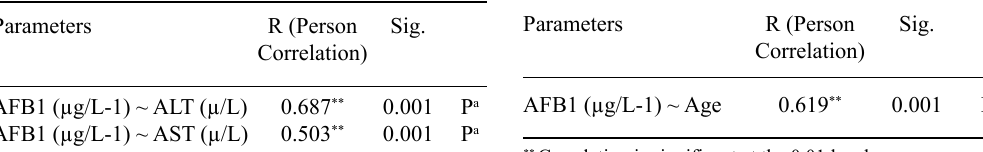
table 2. Correlations between AFB1, AST, and ALT Parameters